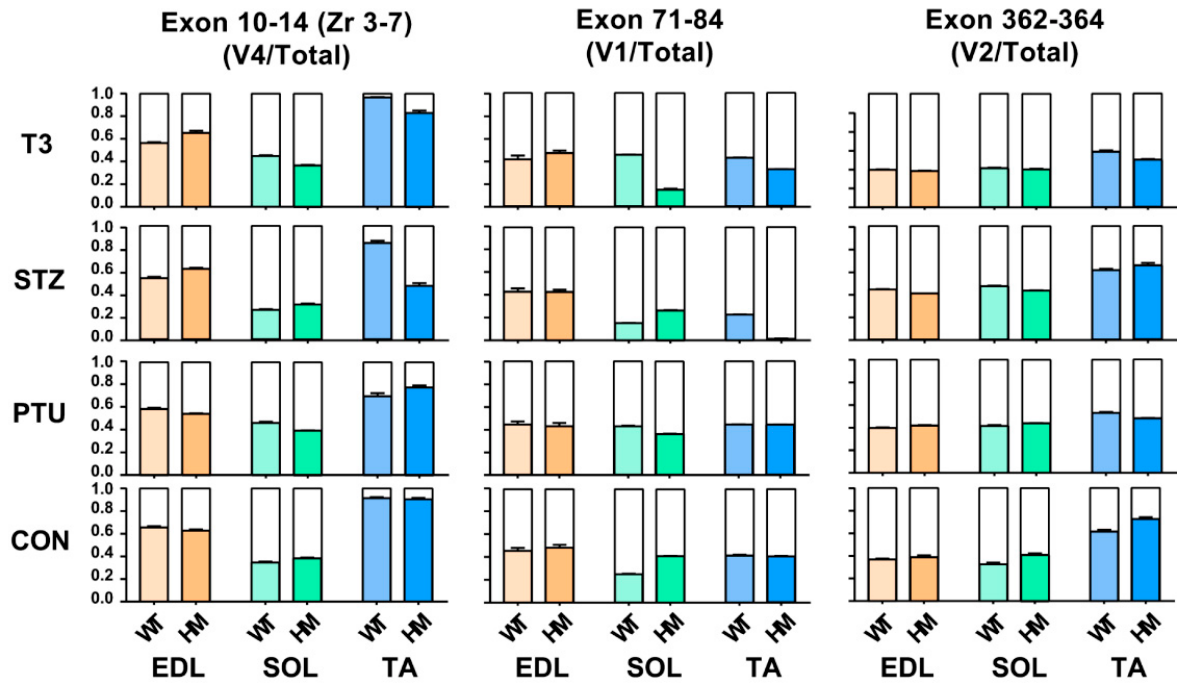
Figure 3. Hormonal effects on titin major splice variants in Z-, I- and M-bands between WT and HM across different muscles. WT, wildtype; HM, RBM20 homozygous knockout; CON, control; PTU, propylthiouracil; STZ, streptozocin; T3, trriodothyronine; TA, tibialis anterior; EDL, extensor digitorum longus; SOL, soleus.